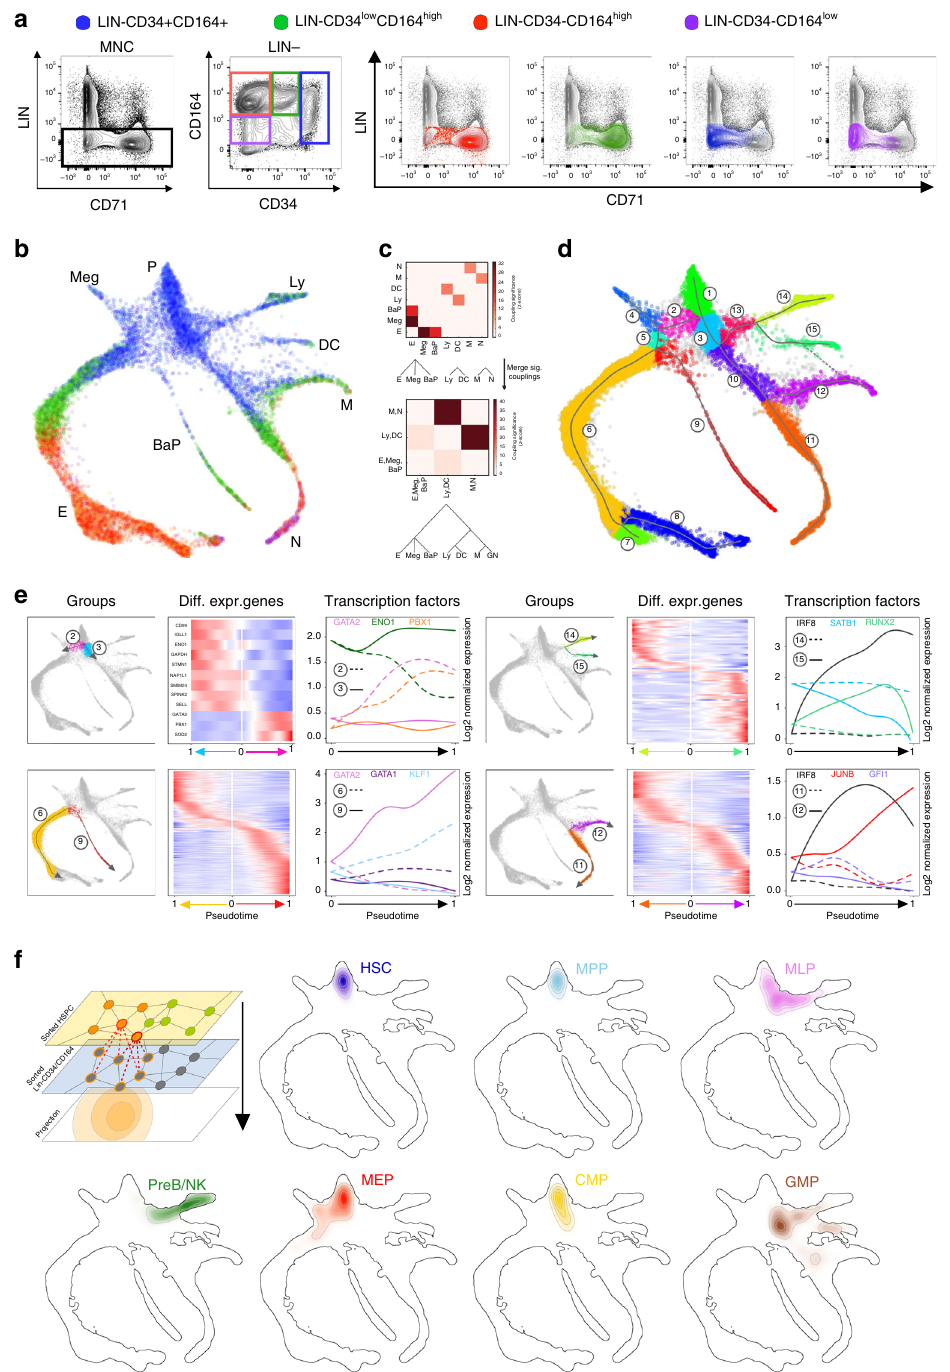
Fig. 2 Human Lin − compartment investigation by means of CD34/CD164 fractionating. a Gating strategy for the FACS sorting of four subsets inside the Lin — fraction of a healthy donor BM, according to CD34 and CD164 expression (left panels). Relative contribution of CD71 + progenitors is shown in the right panels. b SPRING plot of the four Lin − CD34/CD164 subsets single-cell transcriptomes. Each point is one cell. Labels at the edges represent the transcriptional states associated to early lineage commitment (P, early progenitor cells; Meg, megakaryocytes; E, erythroid cells; BaP, basophil progenitors; N, neutrophils; M, monocytes; DC, dendritic cells; Ly-T/B/NK, lymphoid T/B/NK cells). Color legend as in a . Gene expression maps are available in Supplementary Fig. 4. c Predicted hierarchy based on two steps PBA. d Classi fi cation of individual cells into homogenous transcriptional groups numbered from 1 to 15, based on inferred principal trajectories. Solid lines show results based on fi nal converged iteration (Supplementary Fig. 3b for details). Dashed lines added manually to highlight a potential additional trajectory not present in fi nal iteration and inferred by visual inspection (DC-M). e Gene dynamics associated to branching and fate decisions. Plots on the left, branching and groups; mirror heatmaps, expression of statistically signi fi cant genes differentially expressed along each branch pseudotime (LRT adjusted p value < 0.05). Plots on the right, a selection of three transcription factors differentially expressed along each branch (LRT adjusted p value < 0.05). f Projection of the transcriptional states of the seven HSPCs onto the Lin − CD34/ CD164 map